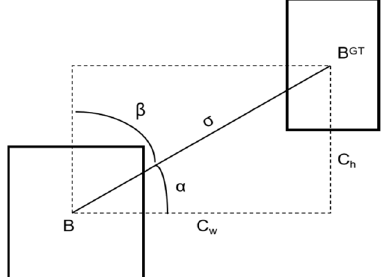
Figure 7. Diagram of SIoU loss function.